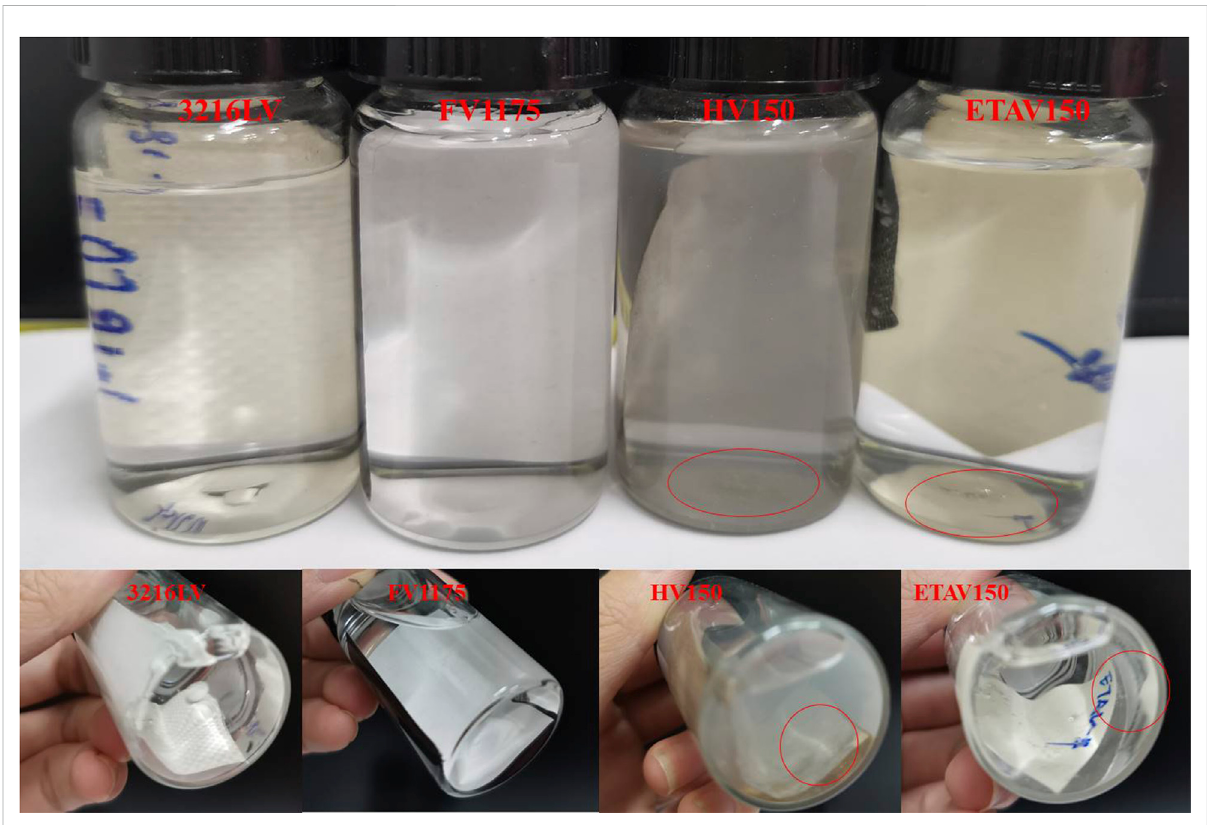
FIGURE 7 Images of aged 3216LV, FV1175, HV150, and ETAV150 soaked in deionized water (ETAV150 was aged for 12 months, and the others were aged for 24